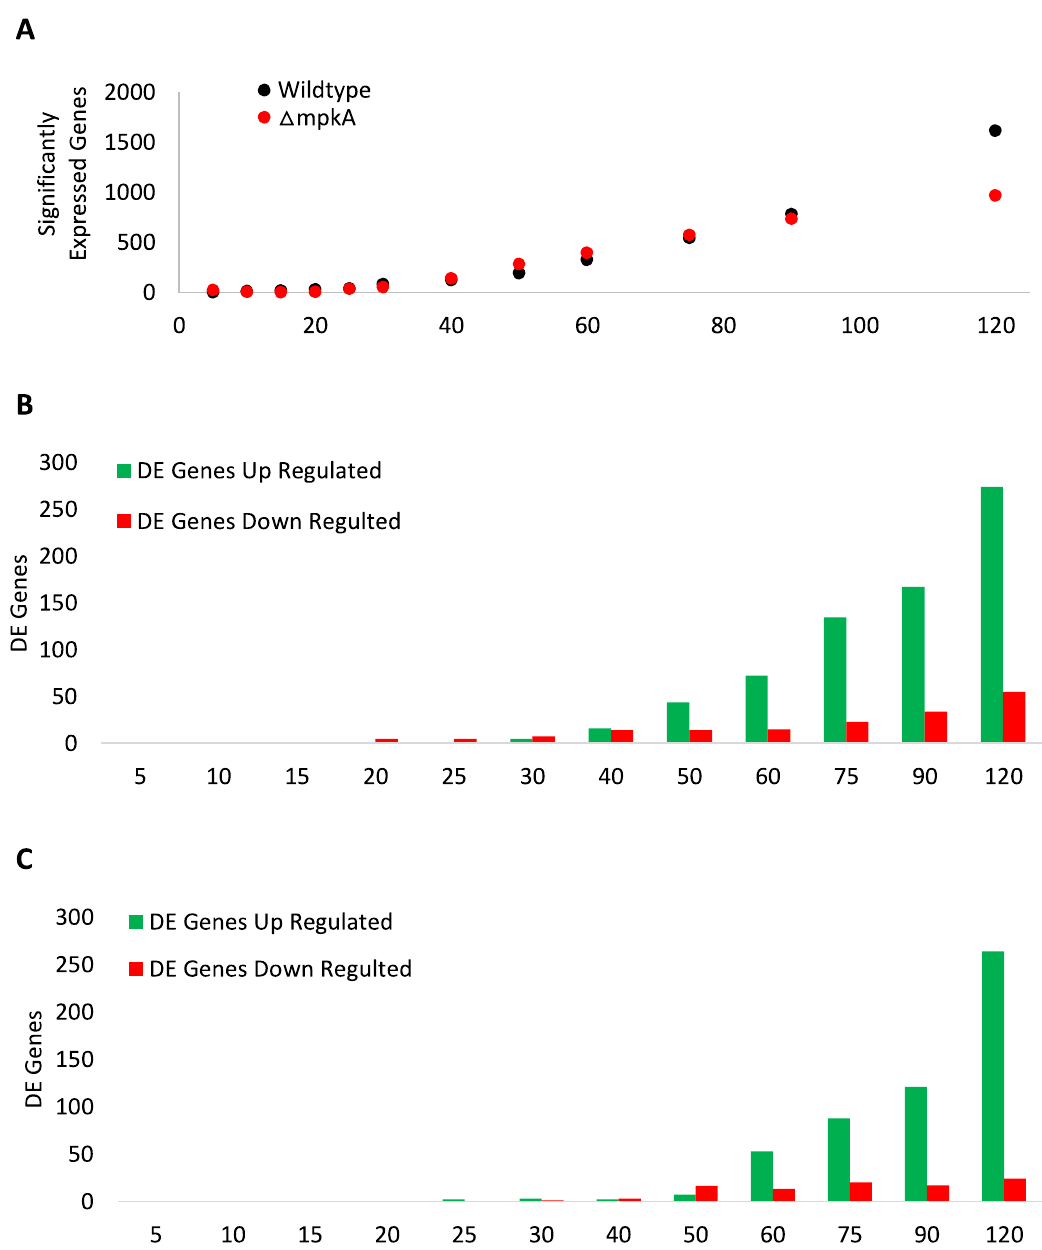
Figure 1. Global Gene Expression ( A ) Wild type showed exponential increase in significantly expressed genes post micafungin exposure. ∆ mpkA showed linear increase in significantly expressed genes post micafungin exposure. Data points for both up-regulated and down-regulated genes. (Significantly expressed genes = p -value < 0.1). Three biological replicates. ( B ) Wildtype DE genes. The first DE gene in wild type was at the 15 min. ( C ) ∆ mpkA DE genes. The first DE gene in ∆ mpkA was at 25 min. (DE genes = adjusted p -value < 0.1, Log2Fold change (+/ − ) 2.0) Three biological replicates. X -axis is minutes.